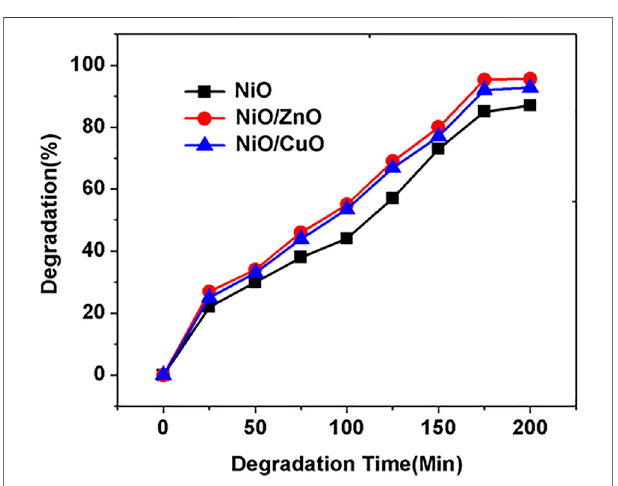
FIGURE 6 | Effect of irradiation time on MB degradation.